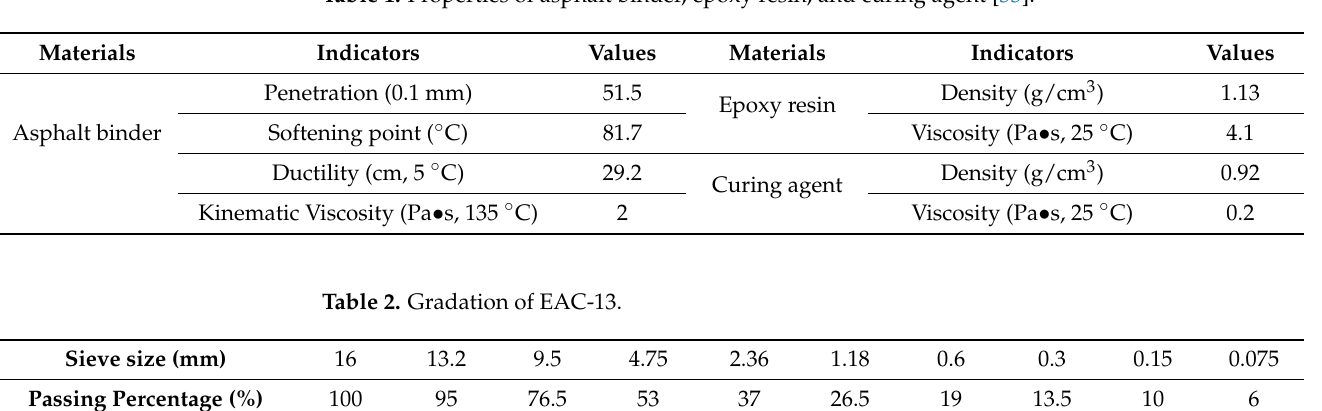
Table 1. Properties of asphalt binder, epoxy resin, and curing agent [33].